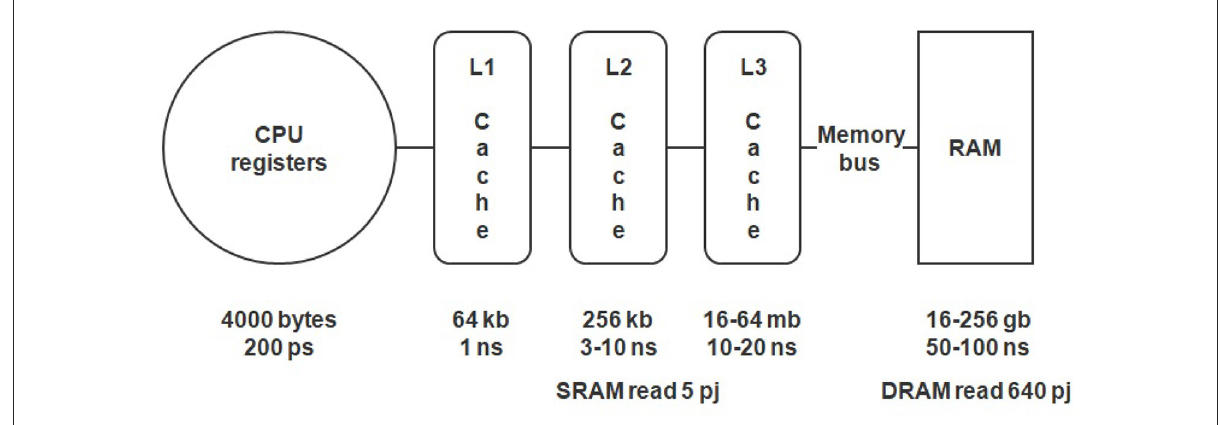
FIGURE1 Memory hierarchy, access speed, and power consumption of a